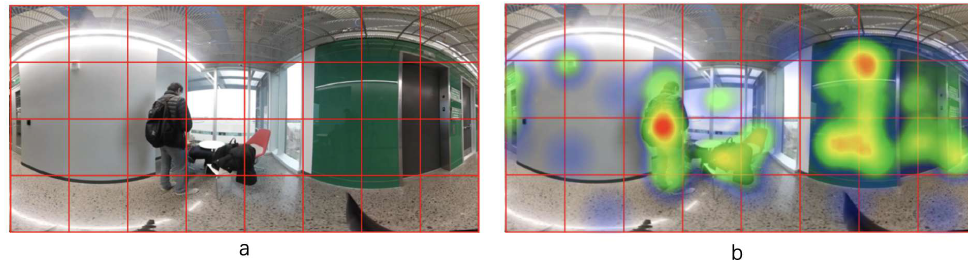
Figure 3. ( a ) VR 4X8 Tiles video frames under ERP projection, ( b ) Heat map of VR 4X8 Tiles video frame saliency under ERP